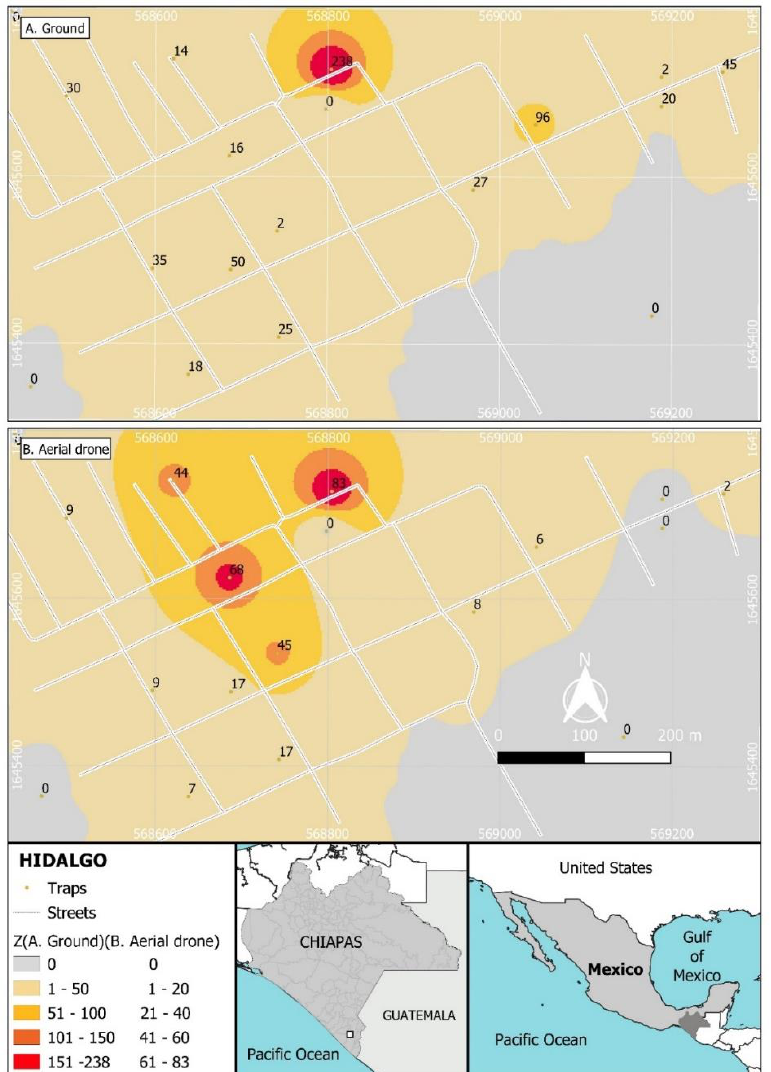
Figure 4. Spatial distribution of recaptures of sterile males of Aedes aegypti released through two methods in the Hidalgo village: ( A ) recaptures from ground release, ( B ) recaptures from aerial release. Colors indicate total recaptures ranging from grey to red (50–200 insects following ground release in ( A ); 20–80 insects following aerial release in ( B )). Values indicate the total numbers of sterile males captured during the 8-week period of both releases.